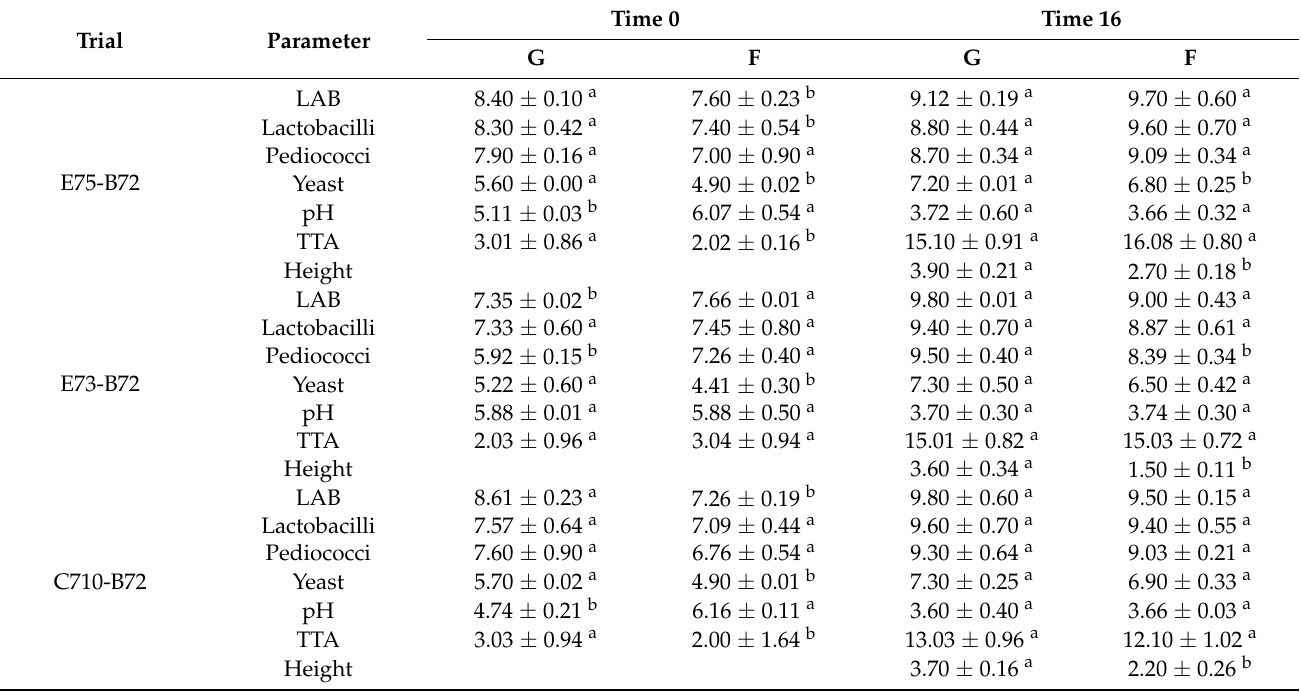
Table 3. Microbial counts (Log CFU/g), pH (units), TTA (mL of NaOH), and height (cm) of fresh (F) and granulated cells (G) at time zero and after 16 h of fermentation. Analyses were performed in triplicate. Results are reported as mean values ± SD. Different superscript letters in a row indicate statistically significant differences between F and G ( p < 0.05).